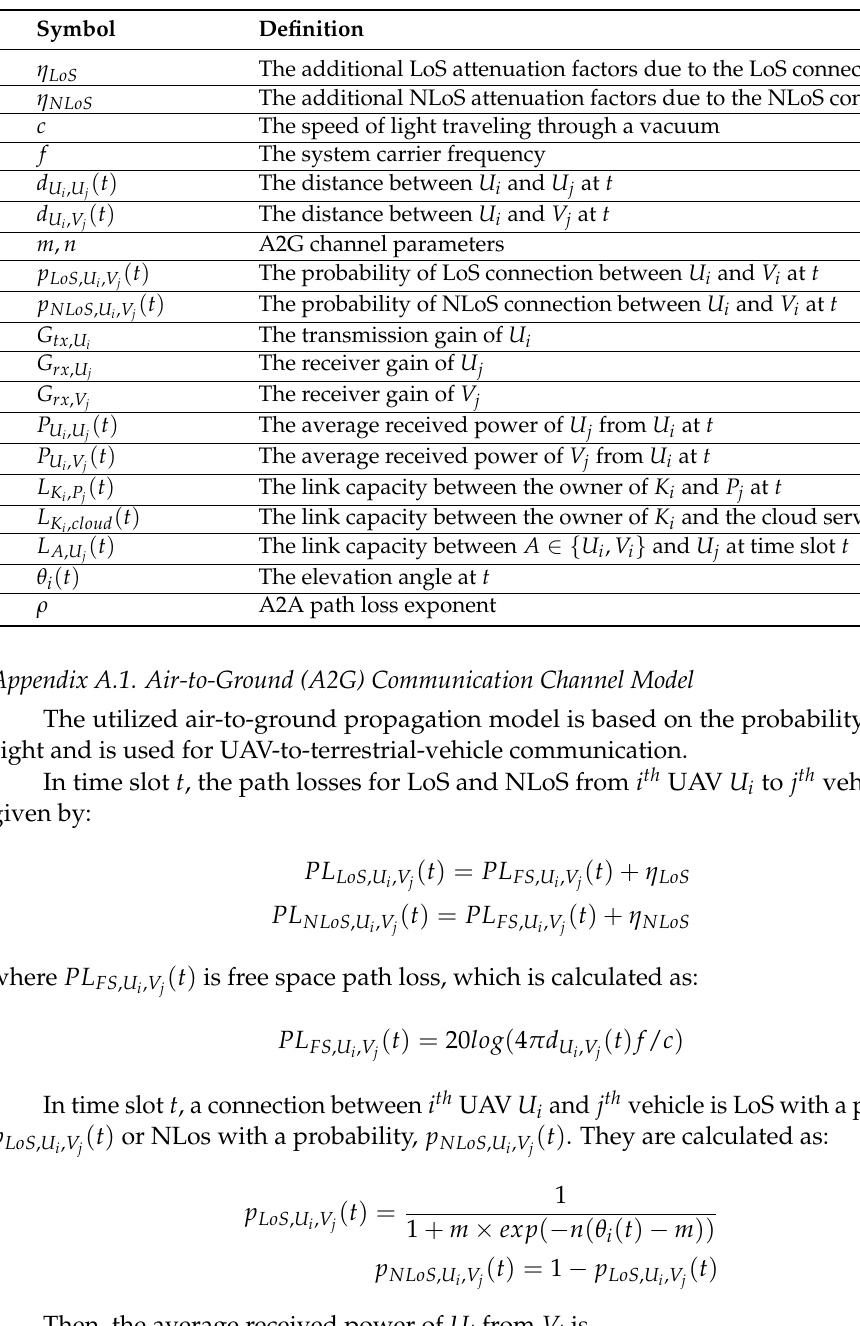
Table A1. Notations used in Channel